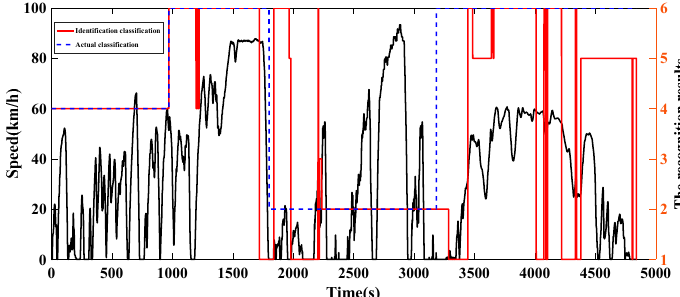
Figure 21. The recognition result of the verification driving cycle.